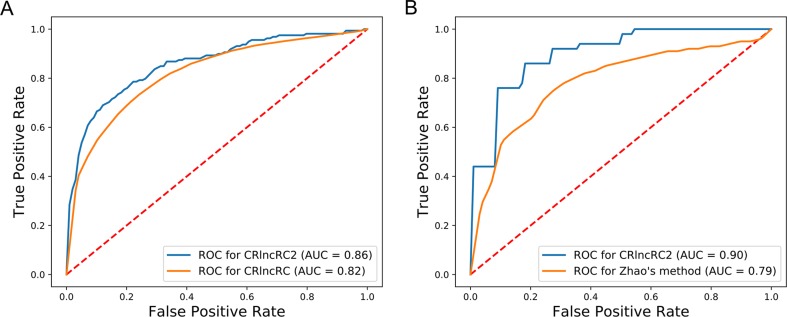
Comparison of accuracy. (A) CRlncRC2 ROC generates an AUC value 0.04 higher than that achieved using CRlncRC. (B) CRlncRC2 ROC generates an AUC value 0.11 higher than that achieved using the method of Zhao et al.